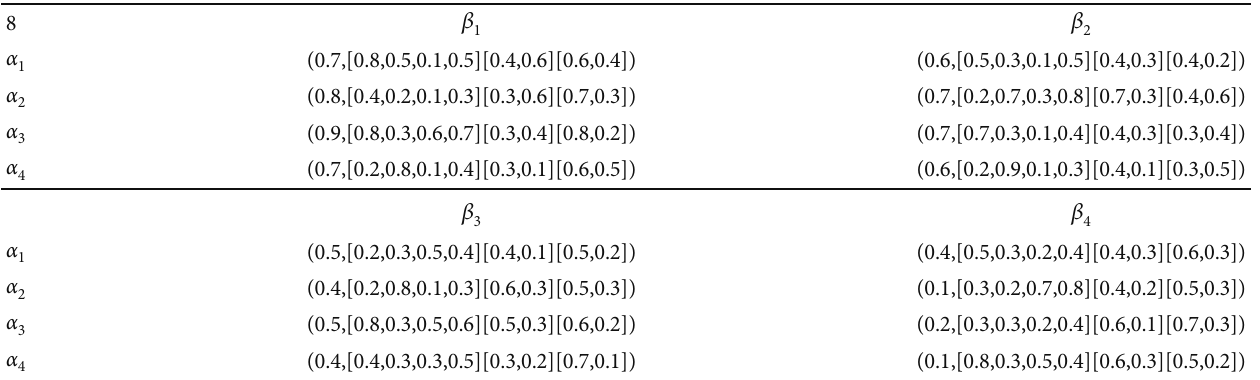
Table 8: Decision matrix of expert -8 (H 8 ).